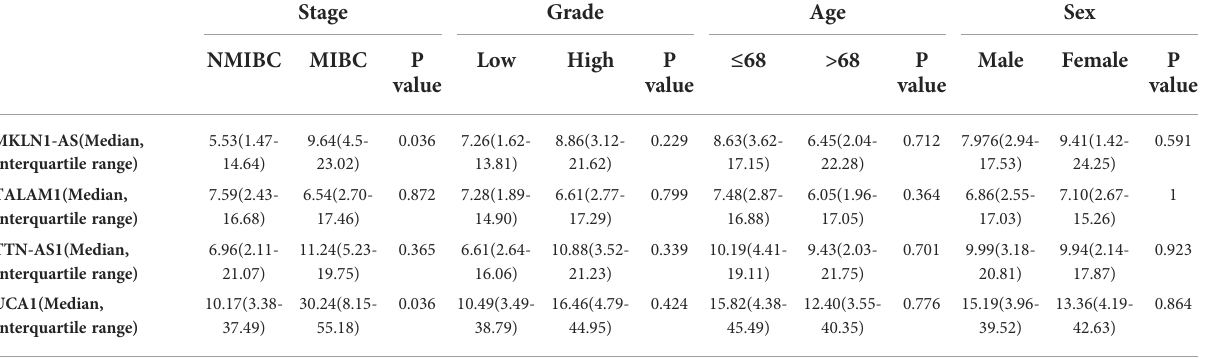
TABLE 2 The correlations between clinical parameters and